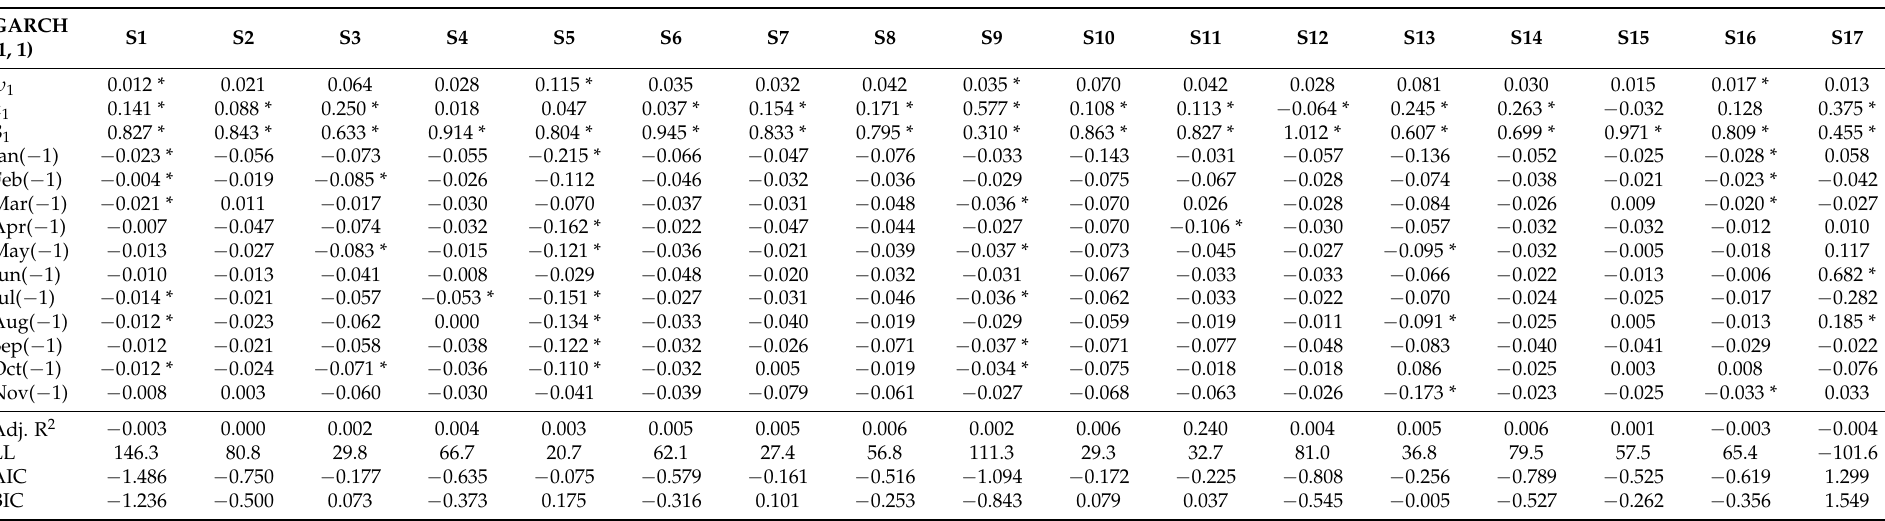
Table 5. GARCH (1,1) conditional variance equation.